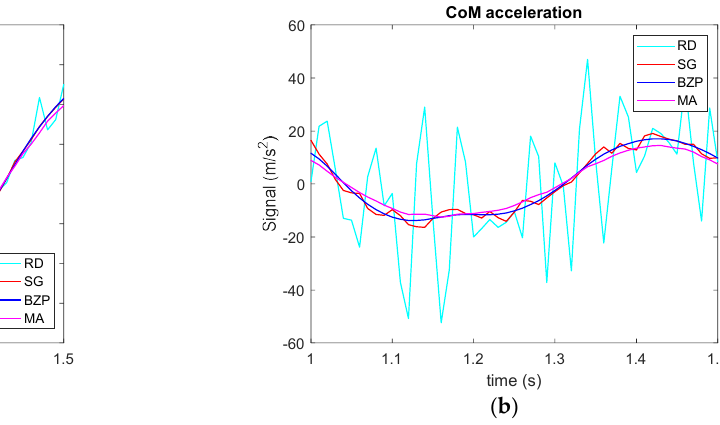
Figure 8. CoM vertical speed ( a ) and acceleration ( b ).